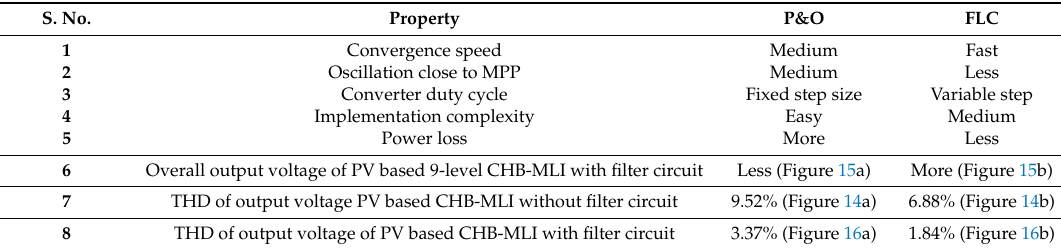
Table 4. Comparison of performance obtained using P&O and FLC MPPT techniques for 9-level PV based